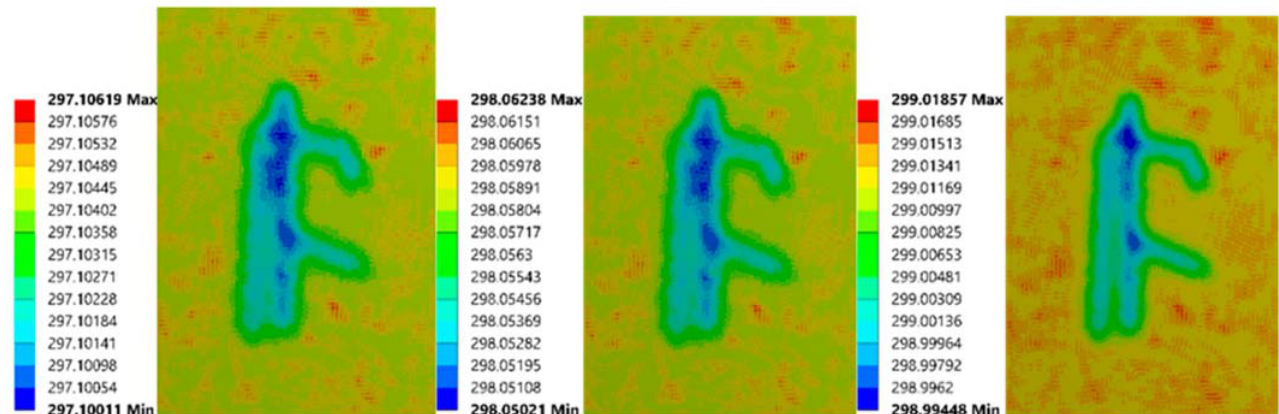
Figure 6. Simulation images of FEA model with heat flux of 0.0005 W/mm 2 , 0.0010 W/mm 2 , 0.0015 W/mm 2 (from left to